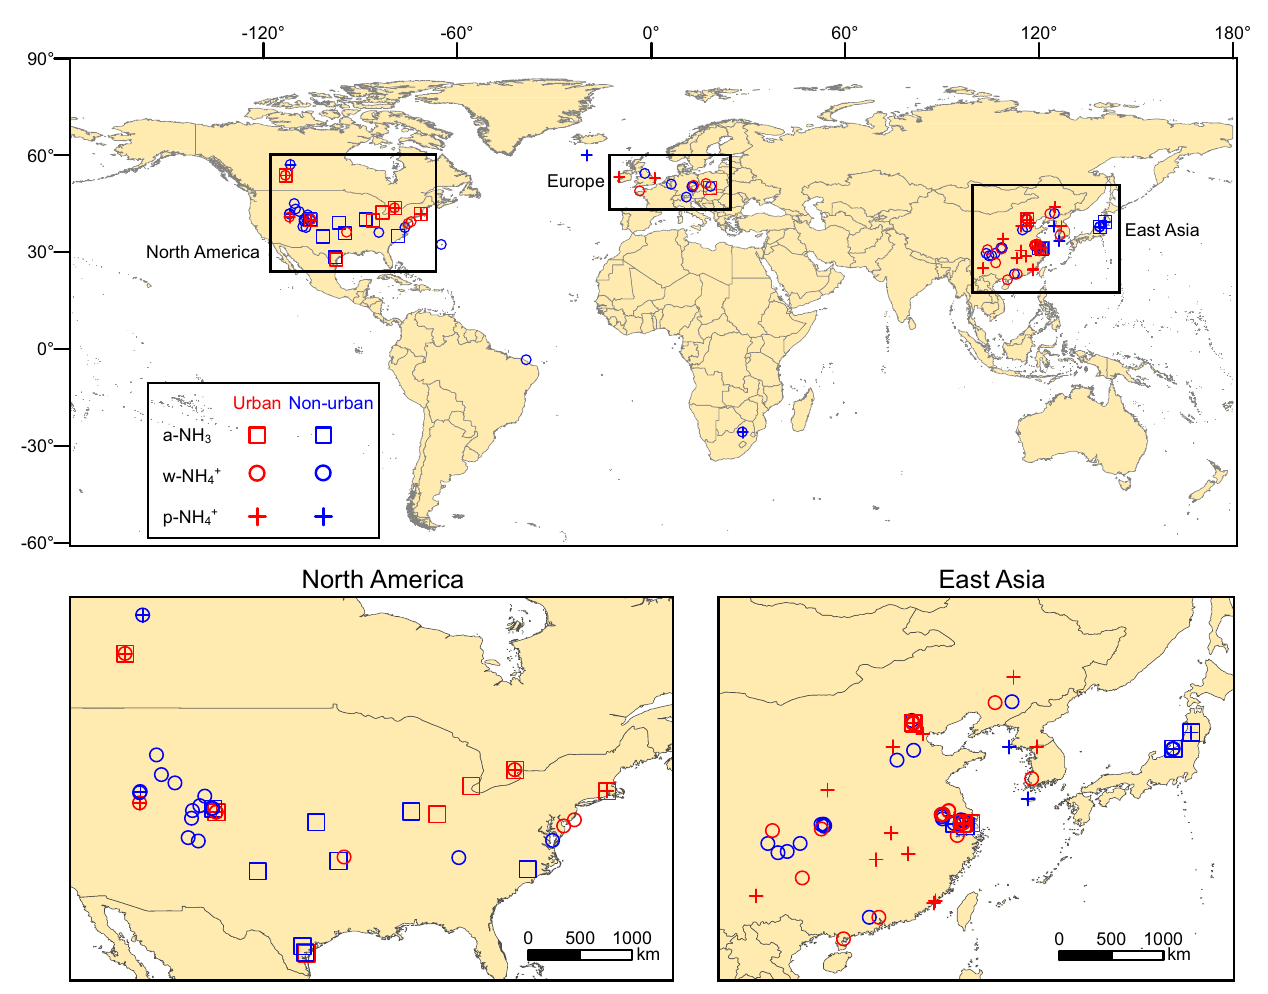
Fig. 2|Globalandregionalmapswiththeobservationsitesfor δ 15 Nofambient NH 3 (a-NH 3 ),particulateNH 4 + (p-NH 4 + ),andprecipitationNH 4 + (w-NH 4 + ) in East Asia,NorthAmerica,andEurope.